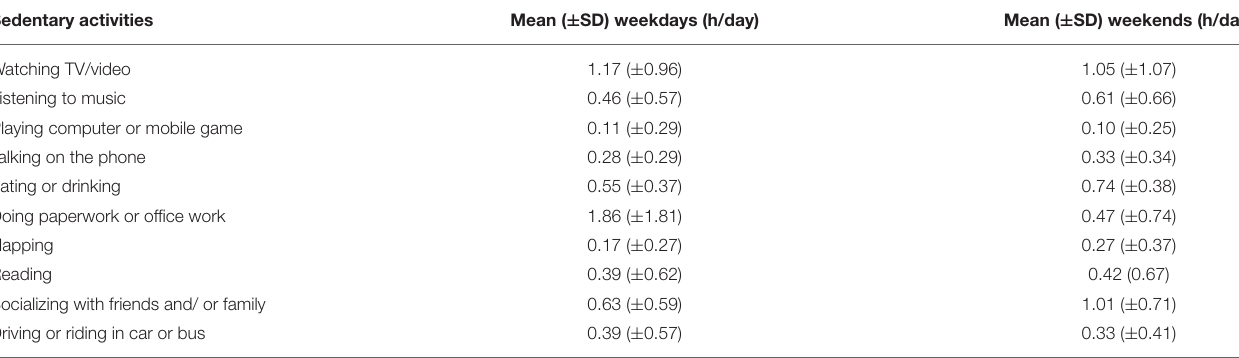
TABLE 4 | Self-report sedentary time by doing different activities among study participants in Eastern Ethiopia, 2019. Sedentary